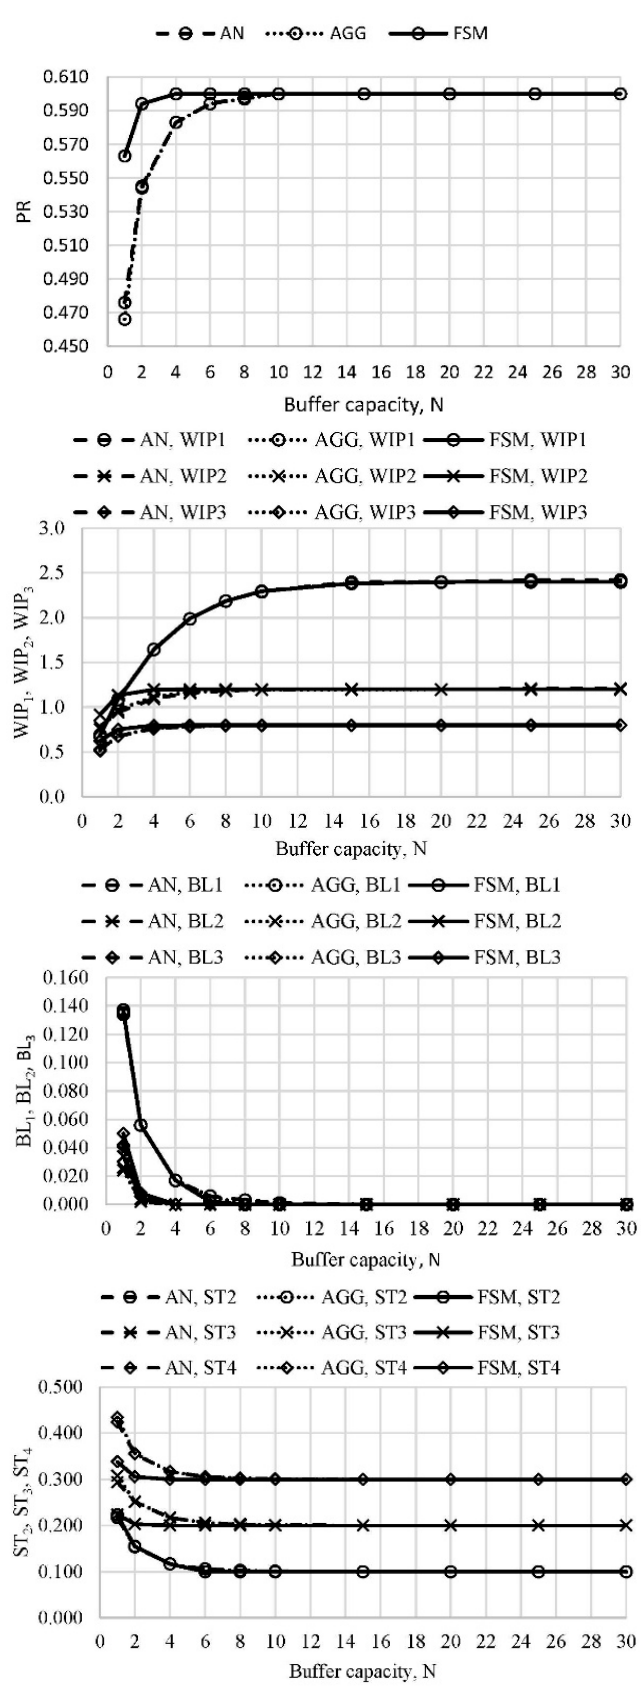
= N, N = 2 N , N = N ) (authors’ 2 3 3A ( N 1